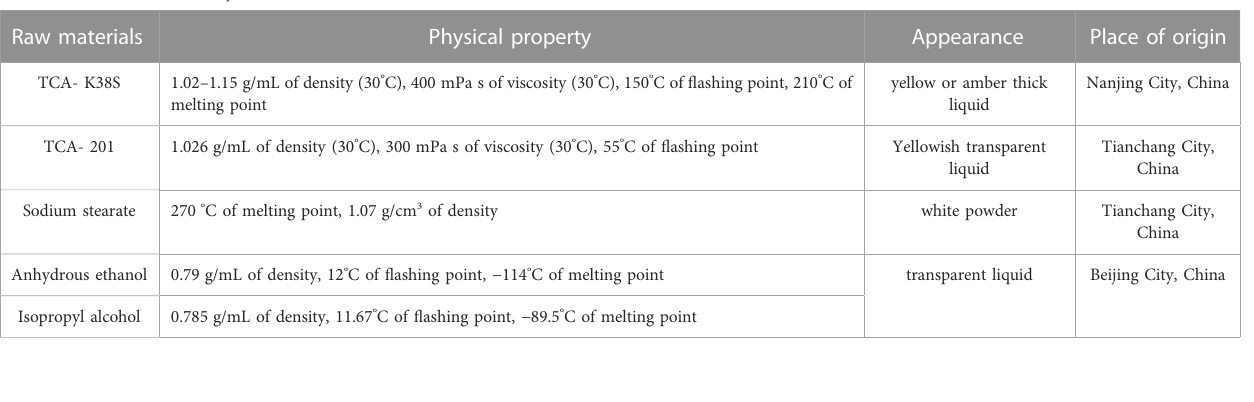
TABLE 2 The main technical parameters of raw materials.